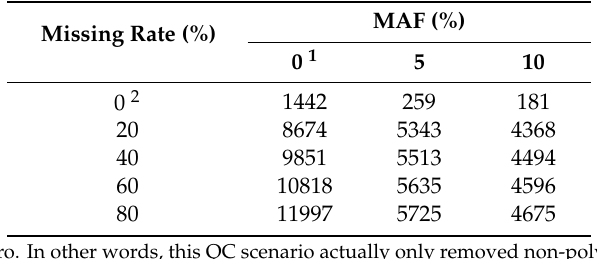
Table 2. Number of markers used for genomic predictions under five missing rate levels (i.e., 0%, < 20%, < 40%, < 60%, and < 80%) and three minor allele frequency (MAF) levels (i.e., > 0%, > 5%, and >